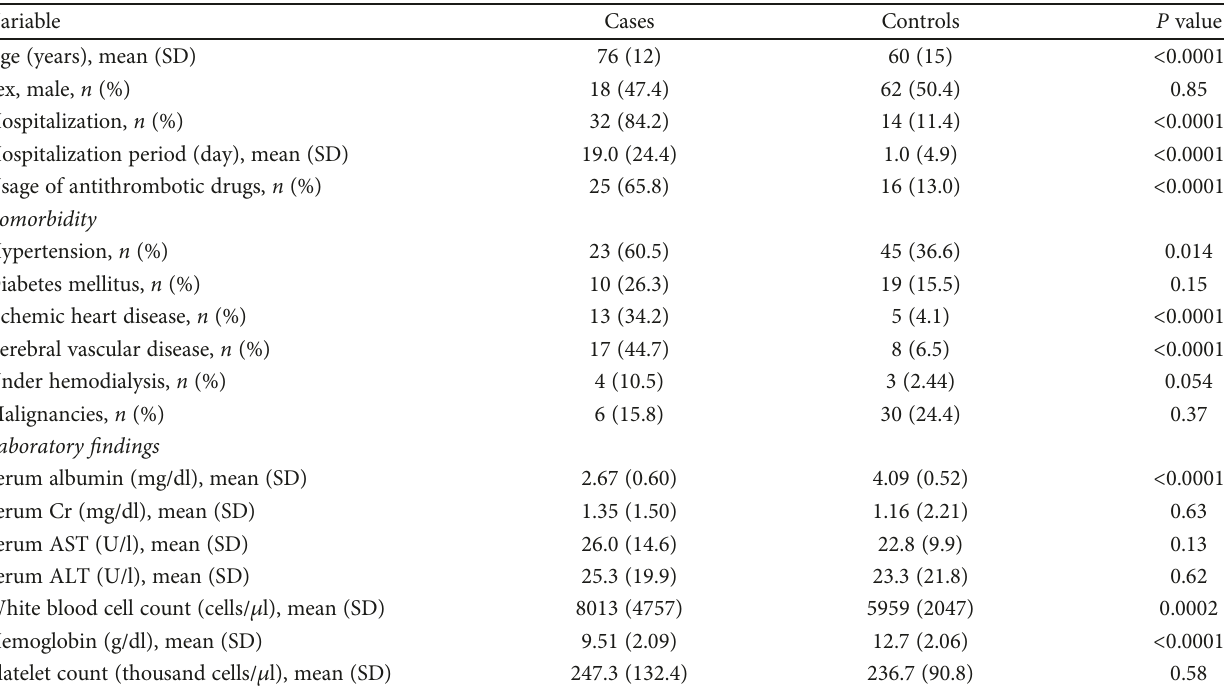
Table 1: Patients ’ characteristics and bivariate analyses.